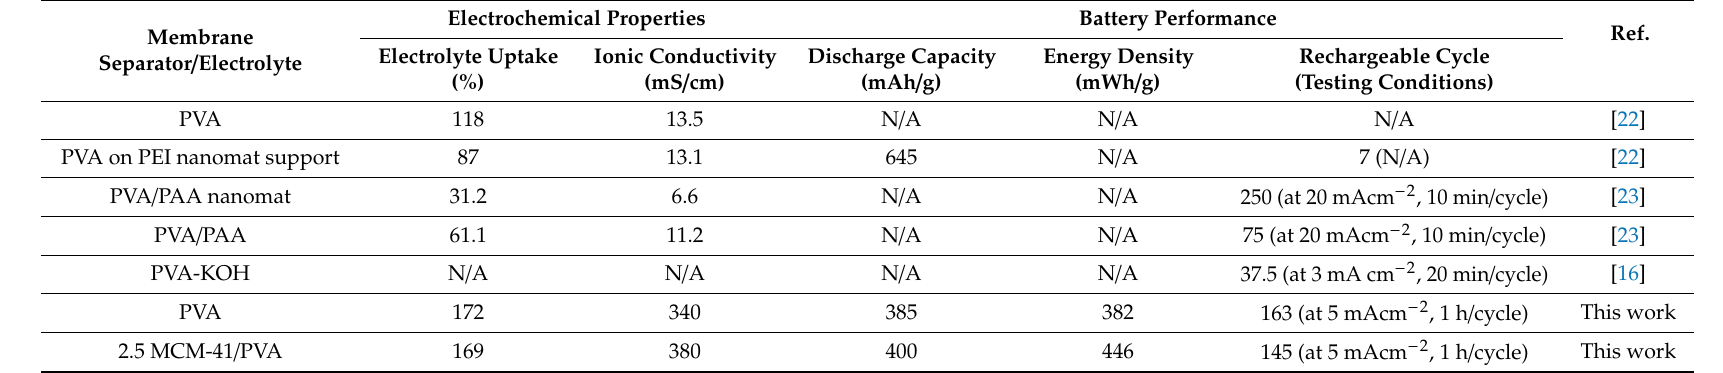
Table 1. Electrochemical properties and battery performance of membranes currently developed for